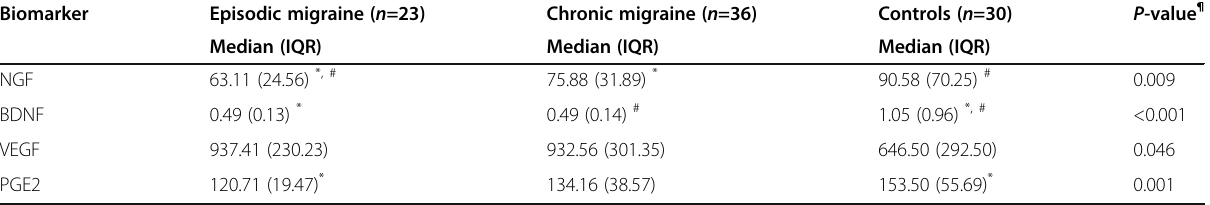
Table 2 Serum levels of NGF, BDNF, VEGF and PGE2 biomarkers in study groups Biomarker